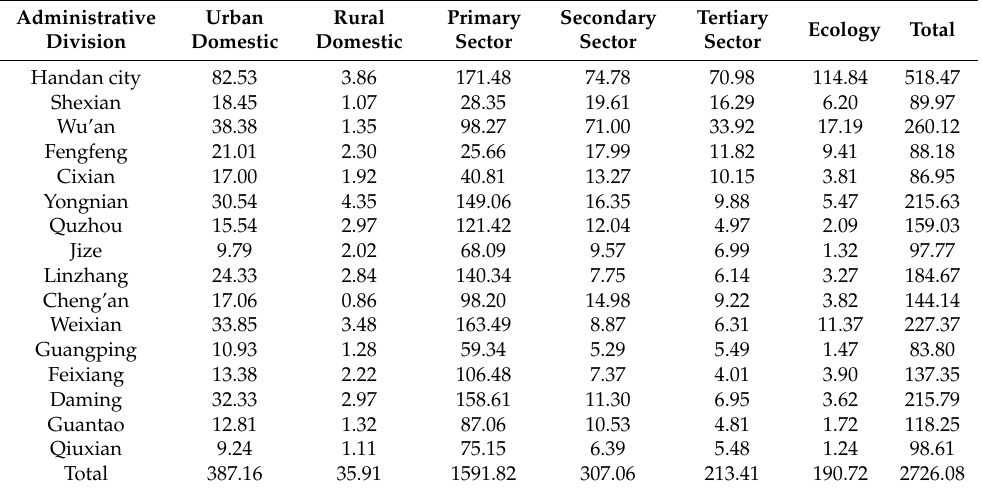
Table 1. Water demand of different water users in each sub-region of Handan in 2030 ( p = 50%) (10 6 m 3 ).